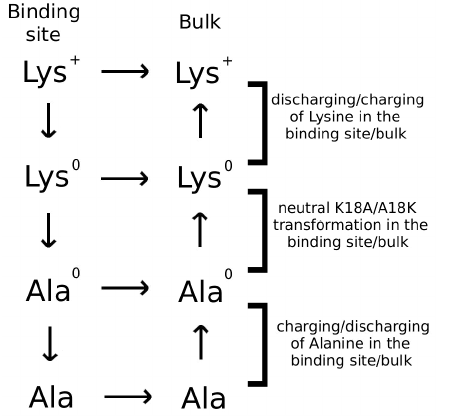
Figure 1. The thermodynamic cycle used in the free energy calculations. The superscript 0 denotes amino acids with no charges